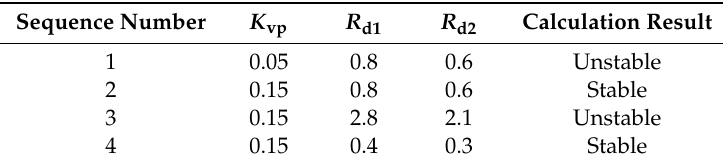
Table 2. Four sets of parameters and the calculations on stability.